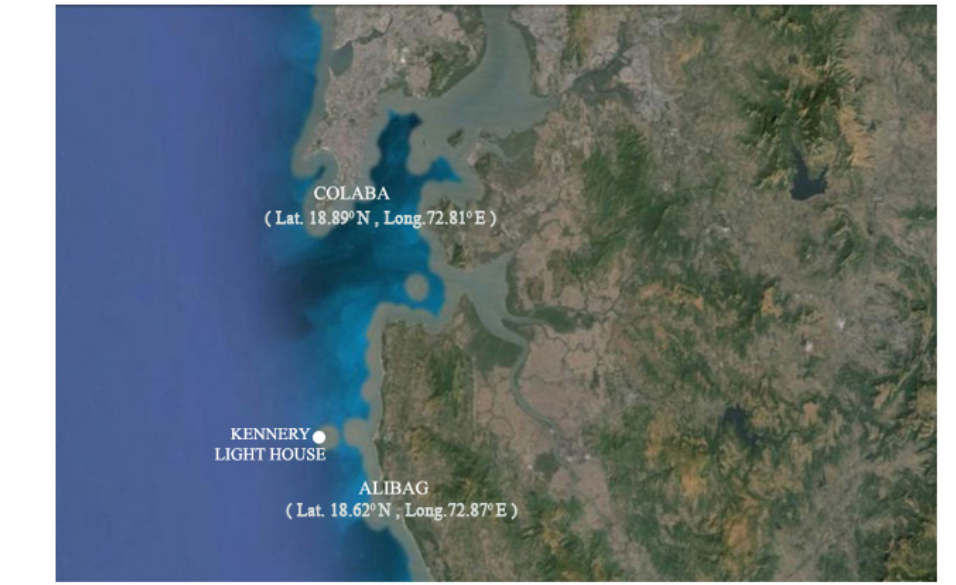
Figure 18. The geographical positions of Colaba and Alibag with respect to each other (source: Google Maps).